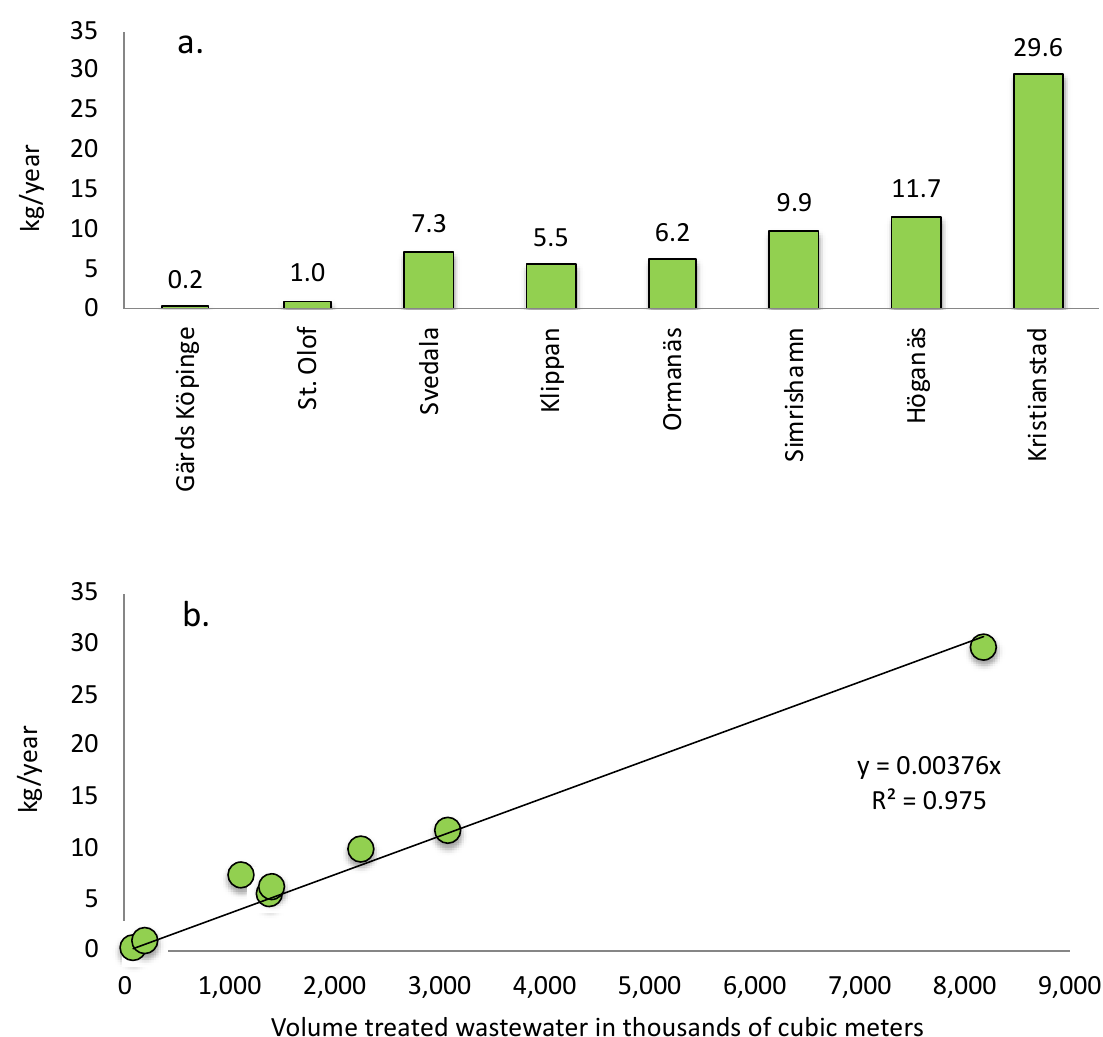
Figure 7. ( a ) Total emission in kg/year of the 21 pharmaceuticals in the 8 Scanian WWTPs. ( b ) Relationship between the emitted amount of pharmaceuticals as the sum of 21 pharmaceuticals in kg/year (y-axis) and the treated wastewater volume in thousands of cubic meters per year. In both panels, the order of the WWTPs is based on size according to Figure 2b.